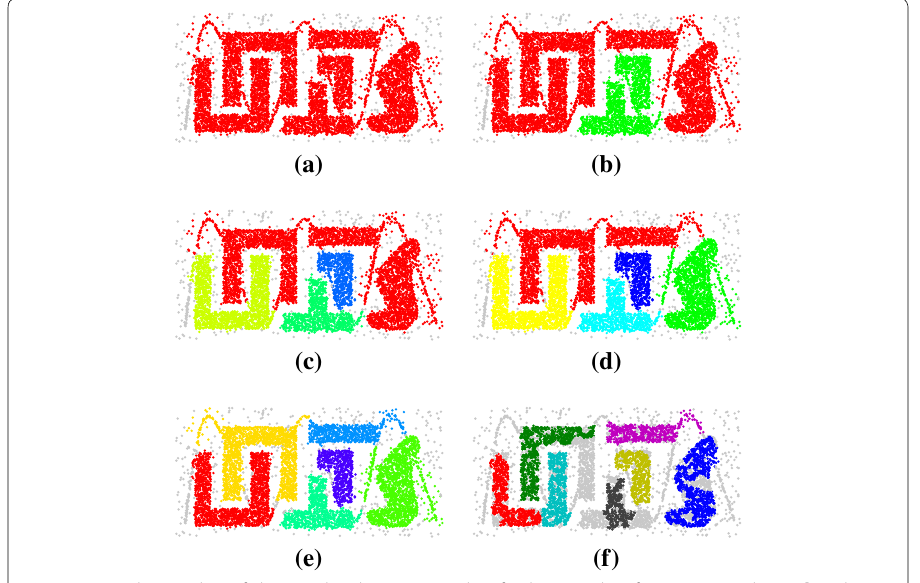
Fig. 4 Given the number of clusters, the clustering results of a dataset taken from [54]. a 1 cluster; b 2 clus- ters; c 4 clusters; d 5 clusters; e 6 clusters; f 7 clusters